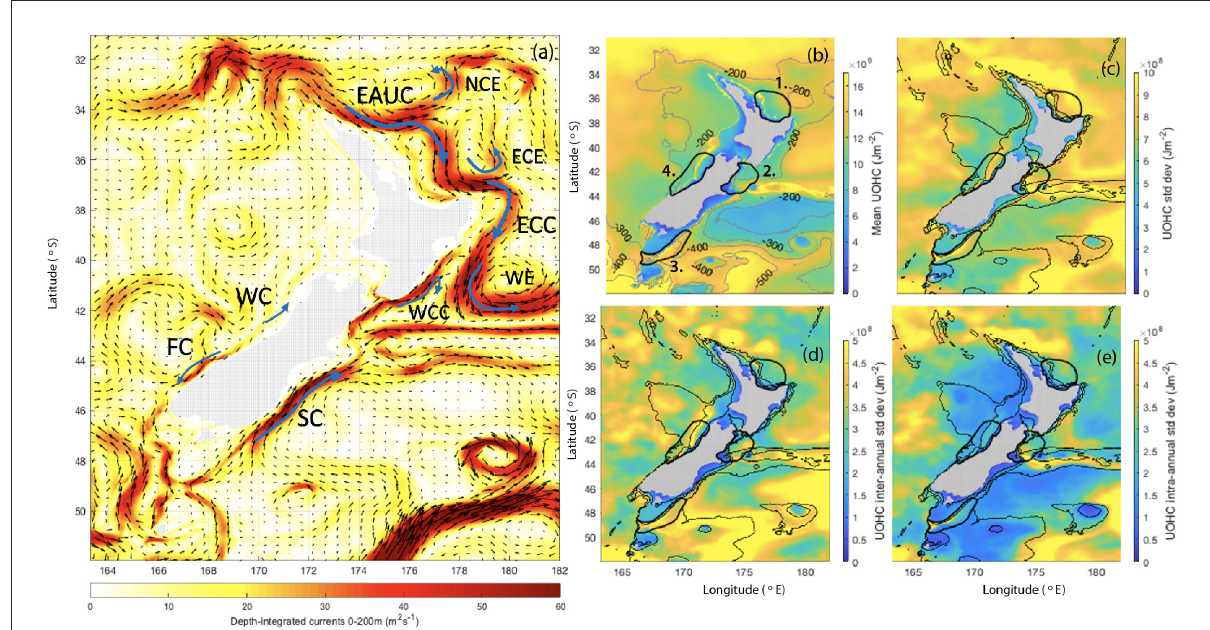
FIGURE1 Depth-integrated currents from 0 to 200 m with schematic of New Zealand’s major currents (a) , mean UOHC with 90 th percentile thermocline depth contours (b) , standard deviation of UOHC (c) , standard deviation of UOHC low-pass filtered at inter-annual periods (d) and standard deviation of UOHC band-pass filtered from 60 to 250 days (e) , computed from the MOANA Ocean Hindcast. The four regions chosen for MHW analysis are labeled on (b) , 1. Bay of Plenty, 2. Kaikoura, 3. Stewart Plateau and Snares Shelf 4. Hokitika. The 100, 400, and 1,000 m depth contours are shown on (c–e) . EAUC, East Auckland Current; NCE, North Cape Eddy; ECC, East Cape Current; ECE, East Cape Eddy; WE, Wairarapa Eddy; WCC, Wairarapa Coastal Current; SC, Southland Current; FC, Fiordland Current; WC, Westland